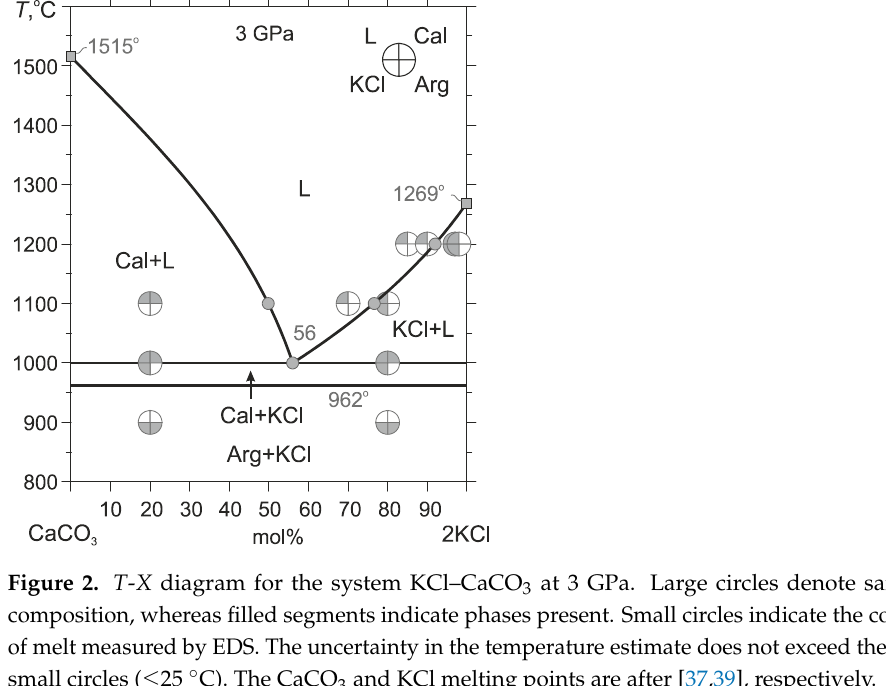
Figure 4. T-X diagram for the system KCl–MgCO 3 at 3 GPa. The MgCO 3 melting point is after [37]. See the caption for Figure 2 for other details.